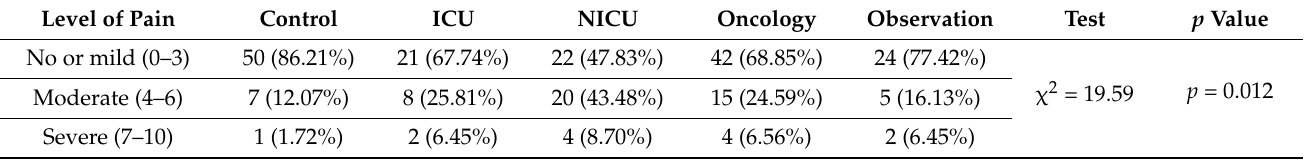
Table 4. A comparison of groups distinguished according to the place of hospitalization of the child with respect to the severity of average